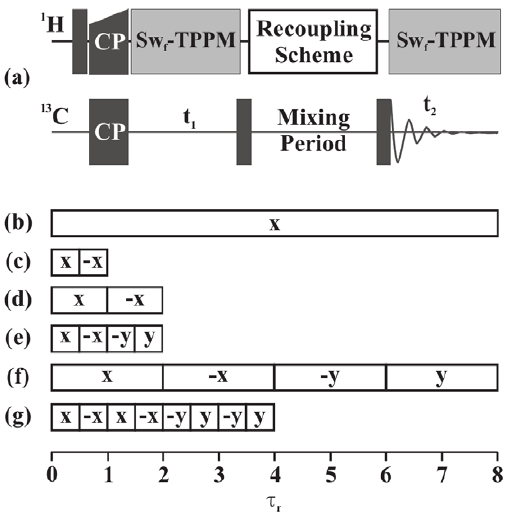
Figure 1. Schematic of recoupling pulse sequence and blocks. (a) General pulse scheme for a 2D 13 C- 13 C spin-diffusion experiment. Second-order recoupling schemes (b) DARR, (c) PARIS (N=1/2), (d) PARIS (N=2), (e) PARIS-xy (m=1)(N=1/2), (f) PARIS-xy (m=1)(N=2), and (g) PARIS-xy (M=2)(N=1/2) are applied on the 1 H channel during the mixing